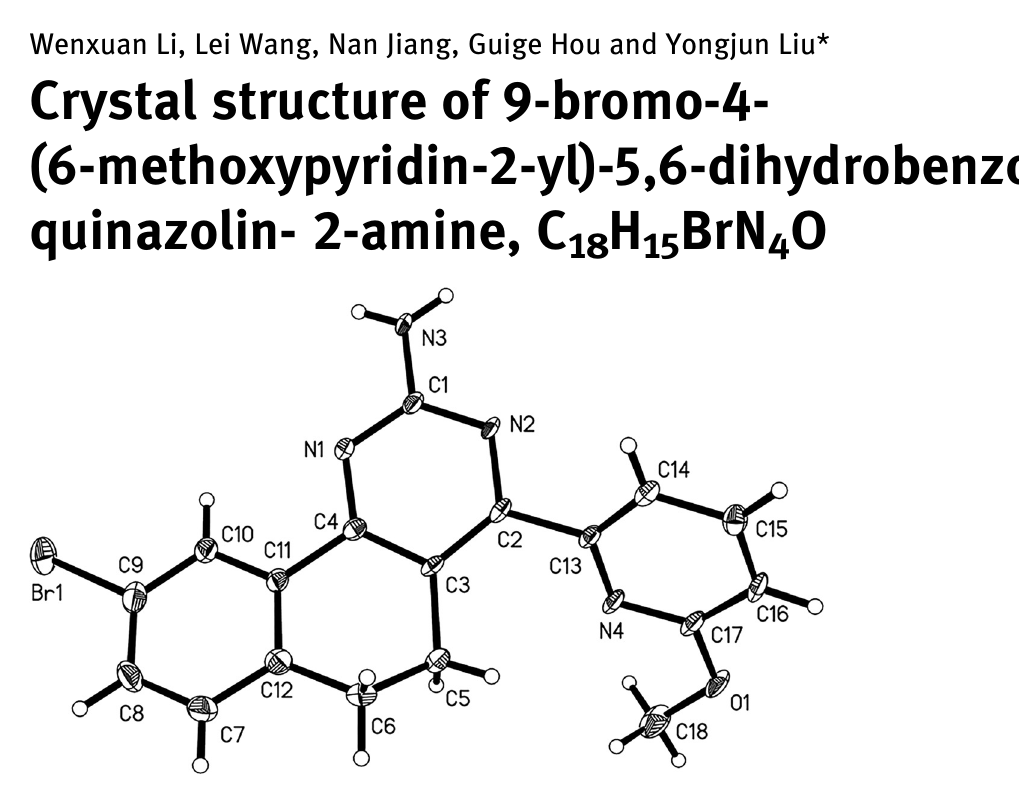
Table  : Data collection and